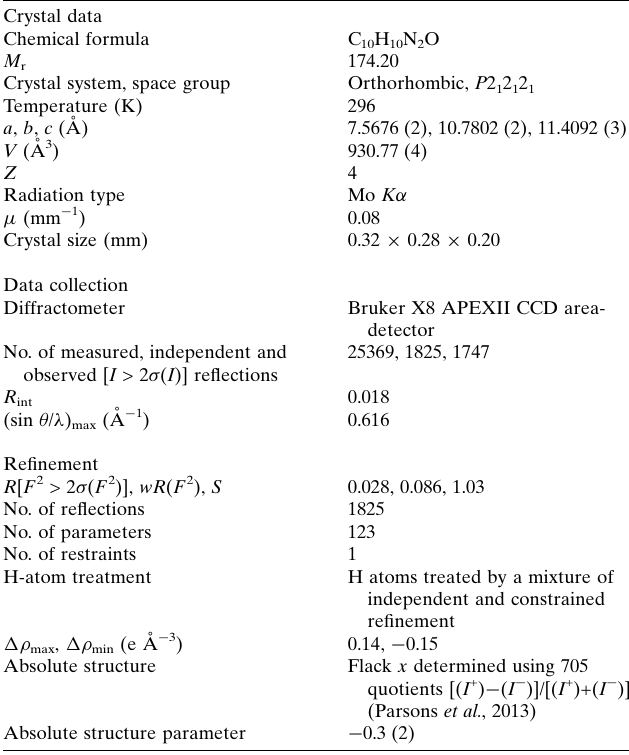
Table 2 Experimental details. Crystal data Chemical formula